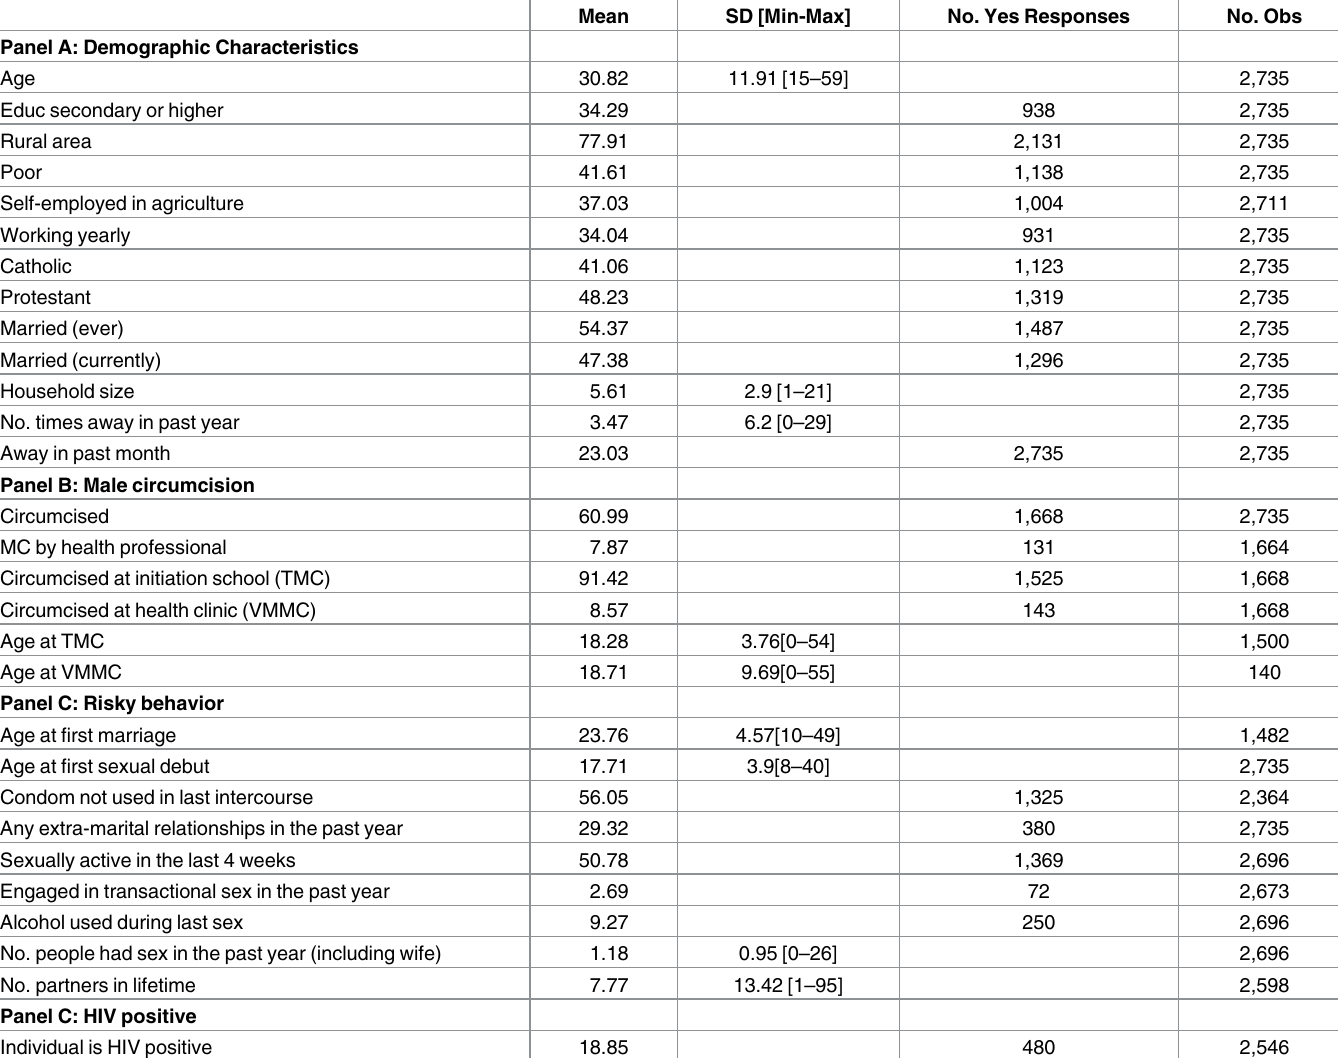
Table 2. Respondents’